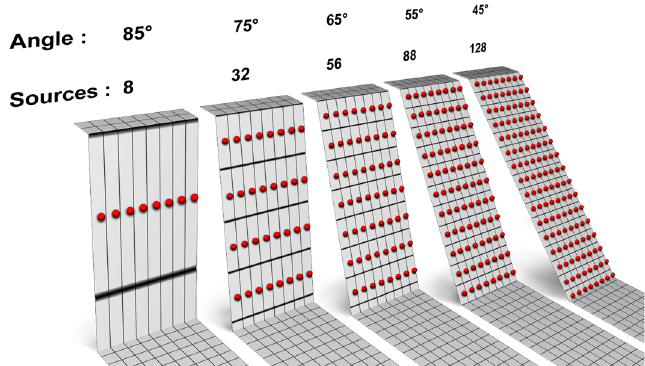
Figure 3. Strong biases affect the source distribution on the gridded DTM (raster). Here, the 45° steep slope has 128 pixels used as rockfall sources while the 85° slope only has 8 pixels that can be rockfall sources.